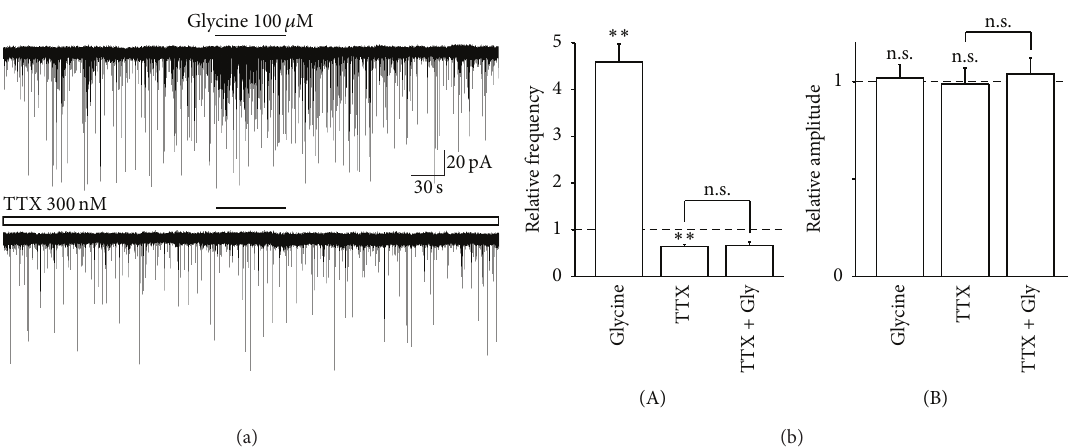
Figure 4: Effect of TTX on glycine-induced increase in sEPSC frequency. (a) Typical traces of glutamatergic sEPSCs observed during the application of 100 𝜇 M glycine in the absence (upper) and presence (lower) of 300 nM TTX. (b) Glycine-induced changes in frequency (A) and amplitude (B) of sEPSC in the absence and presence of TTX. Note that the glycine-induced facilitation of sEPSC frequency was completely suppressed by TTX. Each column was the mean and SEM from 7 neurons. ∗∗ 𝑃 < 0.01 ; n.s.: not significant.